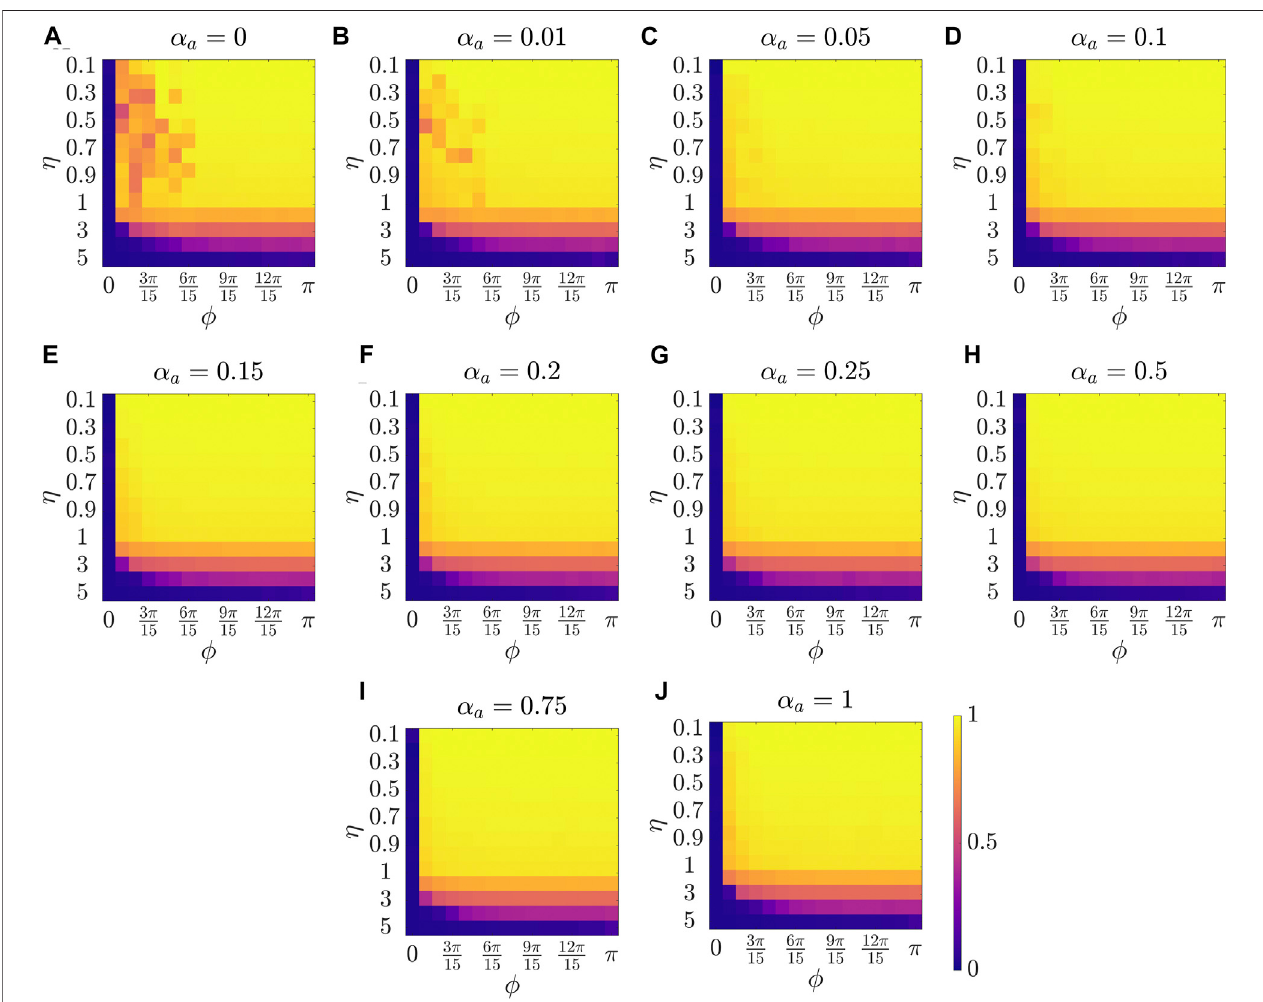
FIGURE2| Resultsforthemeanpolarizationatdifferentvaluesof α a ,shownatthetitleofeachsub- fi gure.Withineachsub- fi gure (A – J) , η isvariedalongthevertical axis, and ϕ is varied along the horizontal axis.